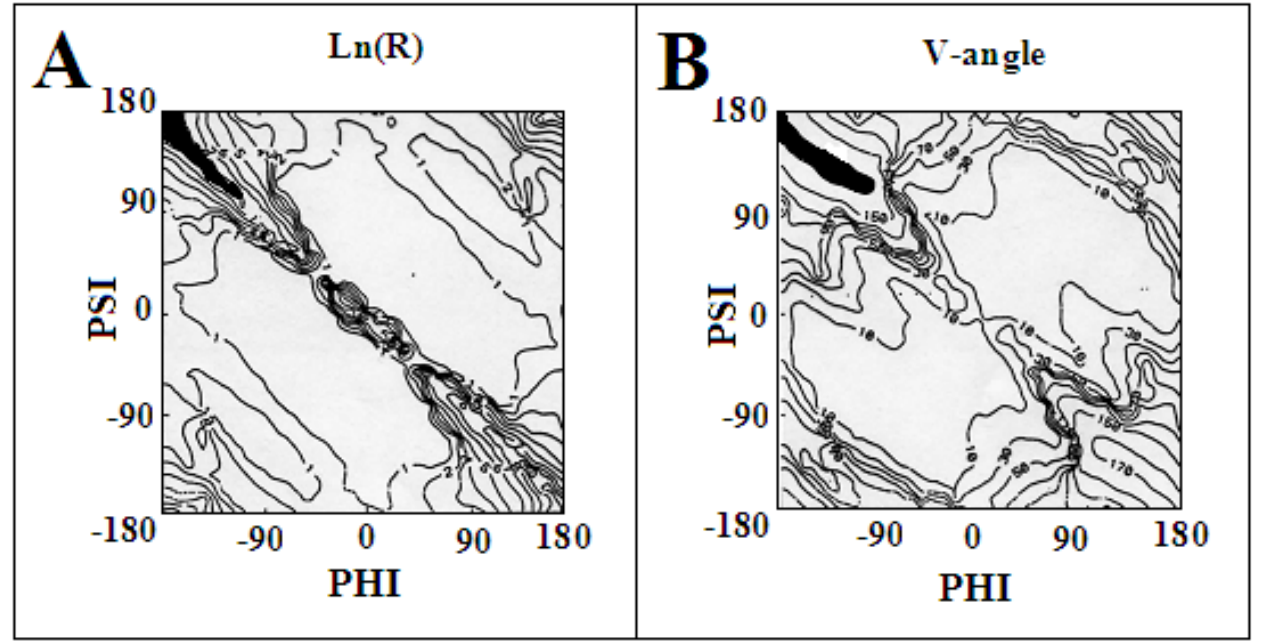
Figure 14. Distribution of the values of geometric parameters describing the polypeptide arrangement: ( A )—radius of curvature on the Ln (R) scale; ( B )—V-angle—angle expressing the relative orientation of the planes of peptide bonds on the virtual C α -C α bond; The maps highlight (black) areas with the highest V-angle values and the highest values of the curvature